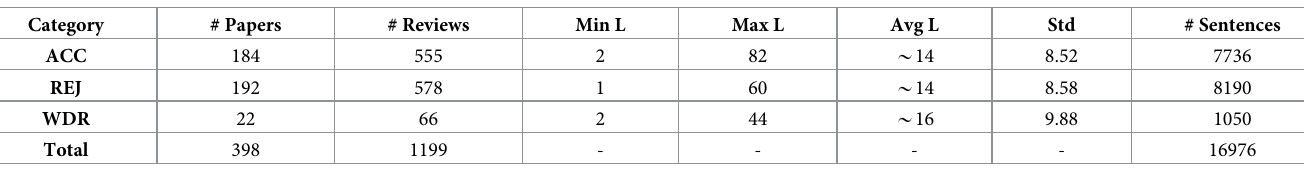
Table 1. Peer review analyze data statistics, L ! # of sentences, Std ! Standard